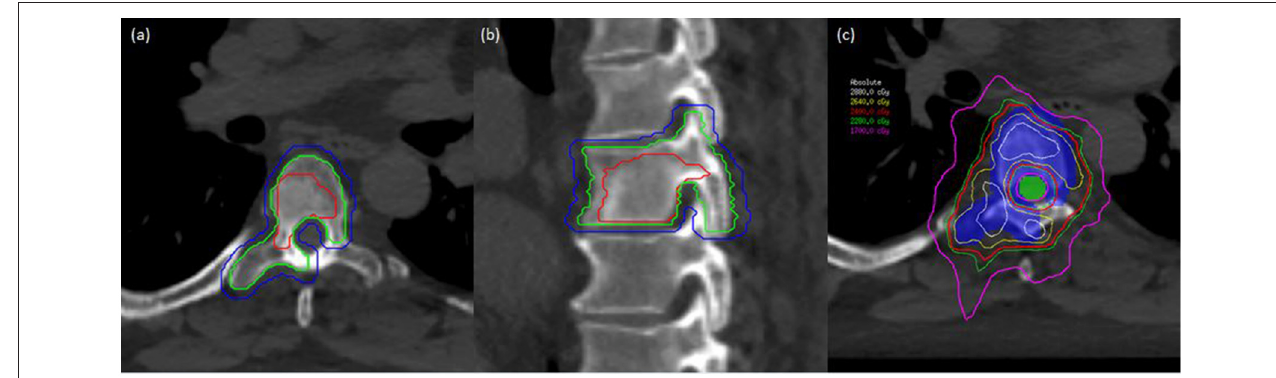
FIGURE 2 | A man with oligometastatic castrate-resistant prostate cancer with painful spine metastases. This man was treated to 24Gy in 2 fractions. (a) Axial planning CT scan demonstrating T6 vertebral level with gross tumor volume (GTV), clinical target volume (CTV), and planning target volume (PTV) delineated with red, green, and blue lines, respectively. (b) Sagittal planning CT demonstrating T6 vertebral level with GTV, CTV, and PTV in red, green, and blue, respectively. (c) Dose distribution at the level of T6 with PTV (colorwash blue) and spinal cord planning organ at risk volume (PRV) in colorwash green. Demonstration of sharp-dose fall-off to respect critical structures while allowing coverage of the target